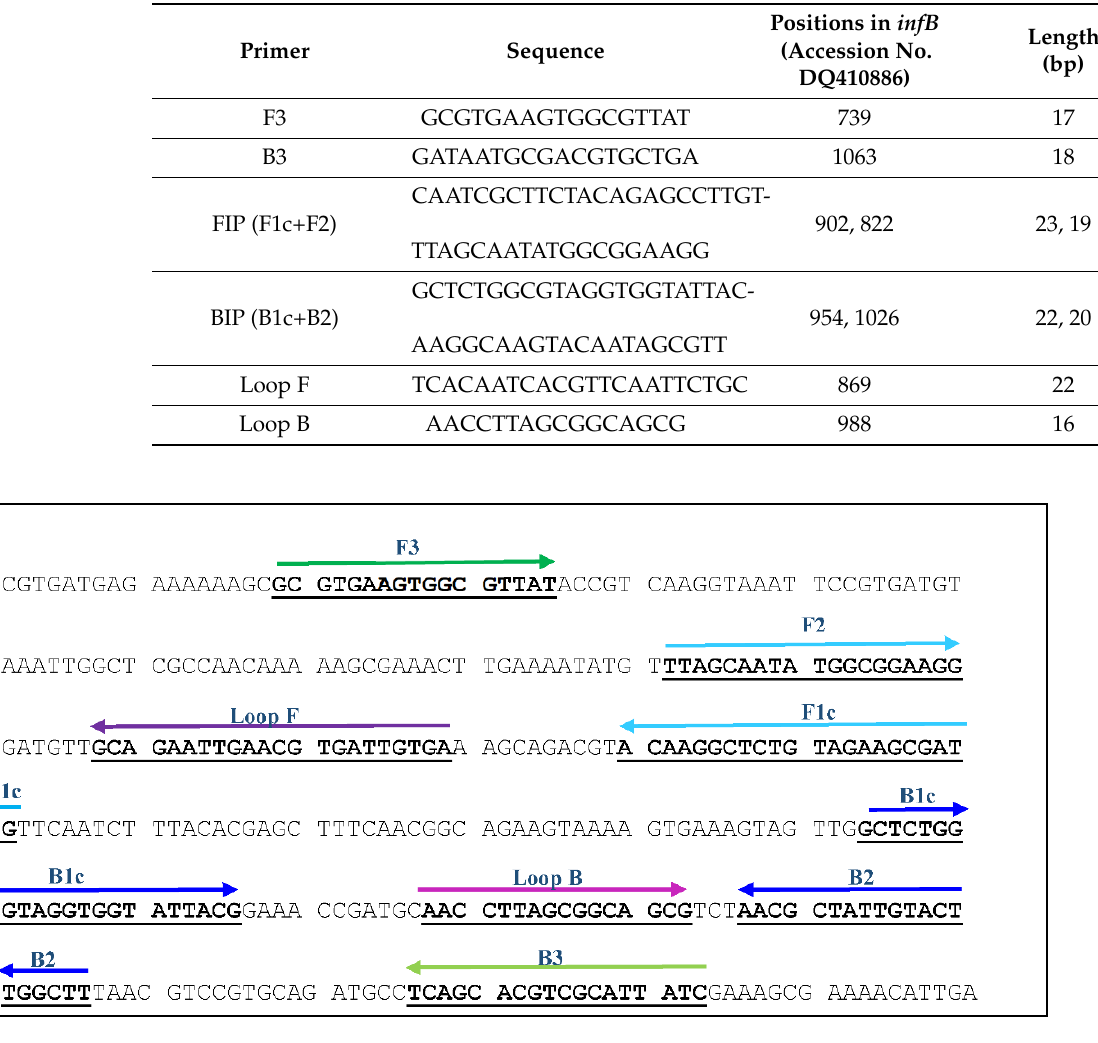
Figure 1. Nucleotide sequence of the infB gene (accession no. DQ410886) with binding positions of the LAMP primers.